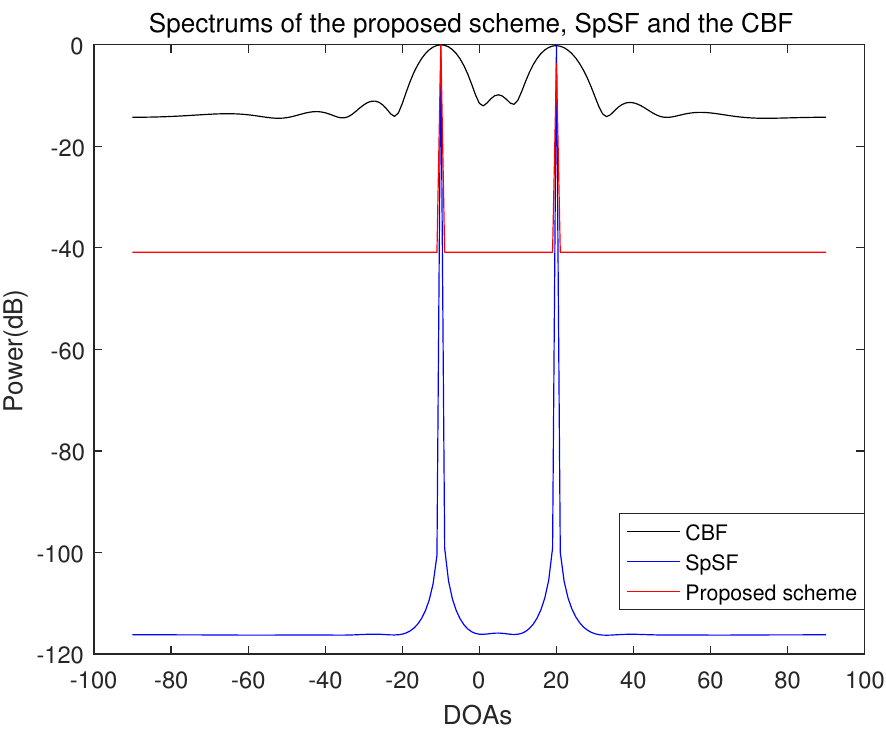
Figure 8. Spectrum of the proposed scheme, SpSF and the conventional beamforming algorithm when the number of sensors is 10, the number of samples is 1000 and the incident angles are − 10 ◦ and 20 ◦ (SNR = 5 dB).